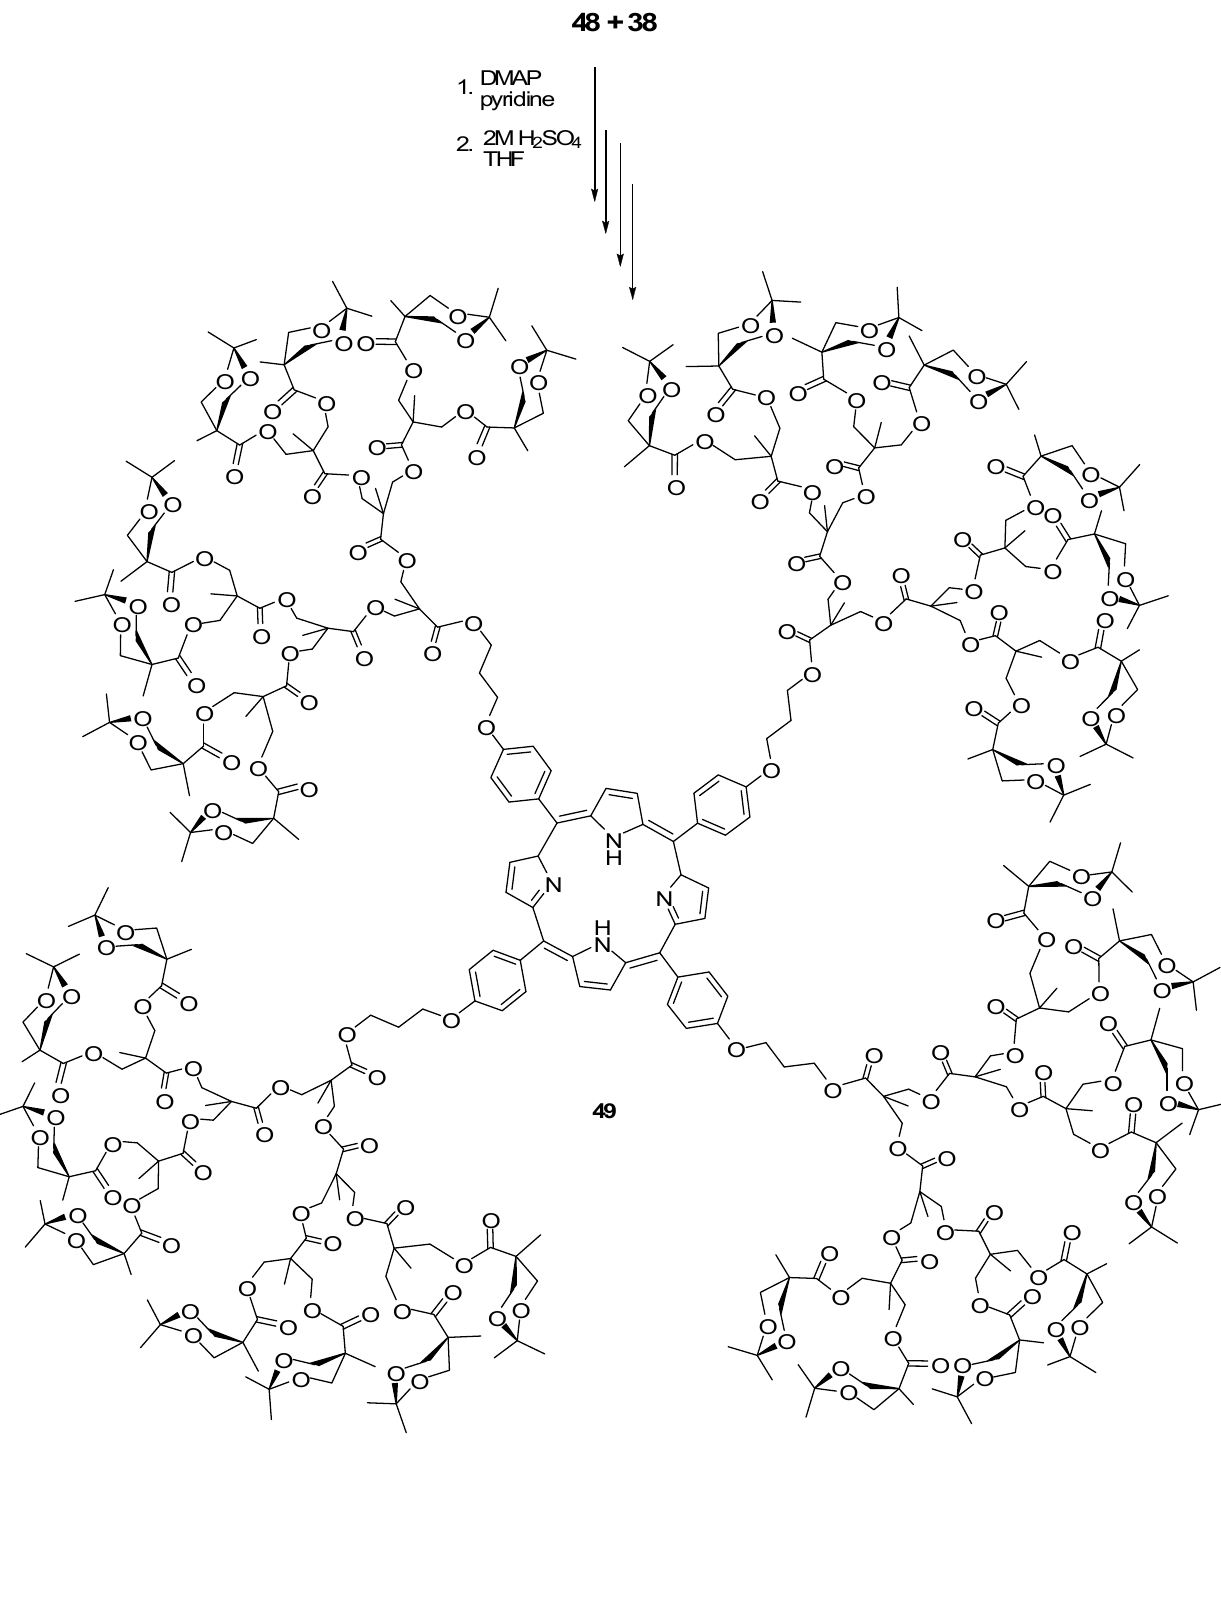
Scheme 28. Divergent construction of a fourth generation (acetonide-protected) free base porphyrin-cored polyester dendrimer